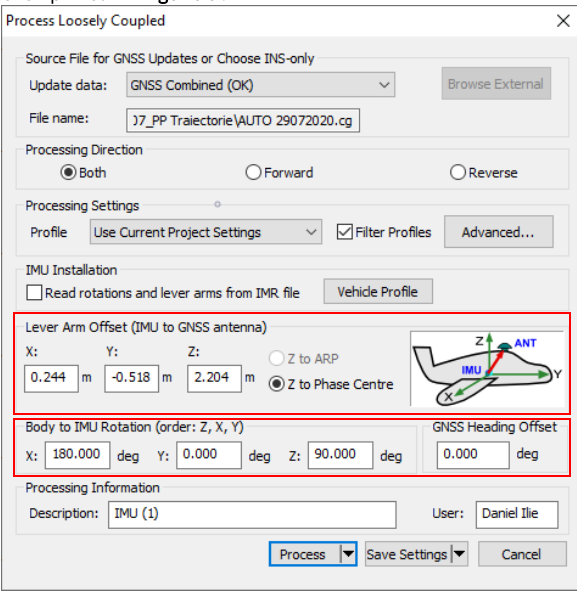
Figure 6 . Calibration of the IMU to GNSS offsets (Lever Arm) and the Body (airplane) to IMU rotations